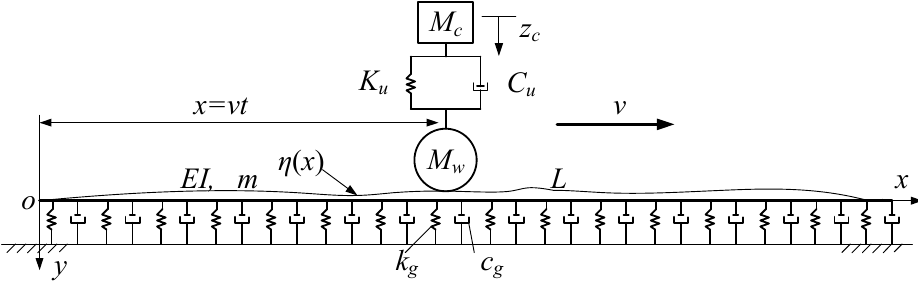
Figure 2. Theoretical calculation model of coupling vibration between train and